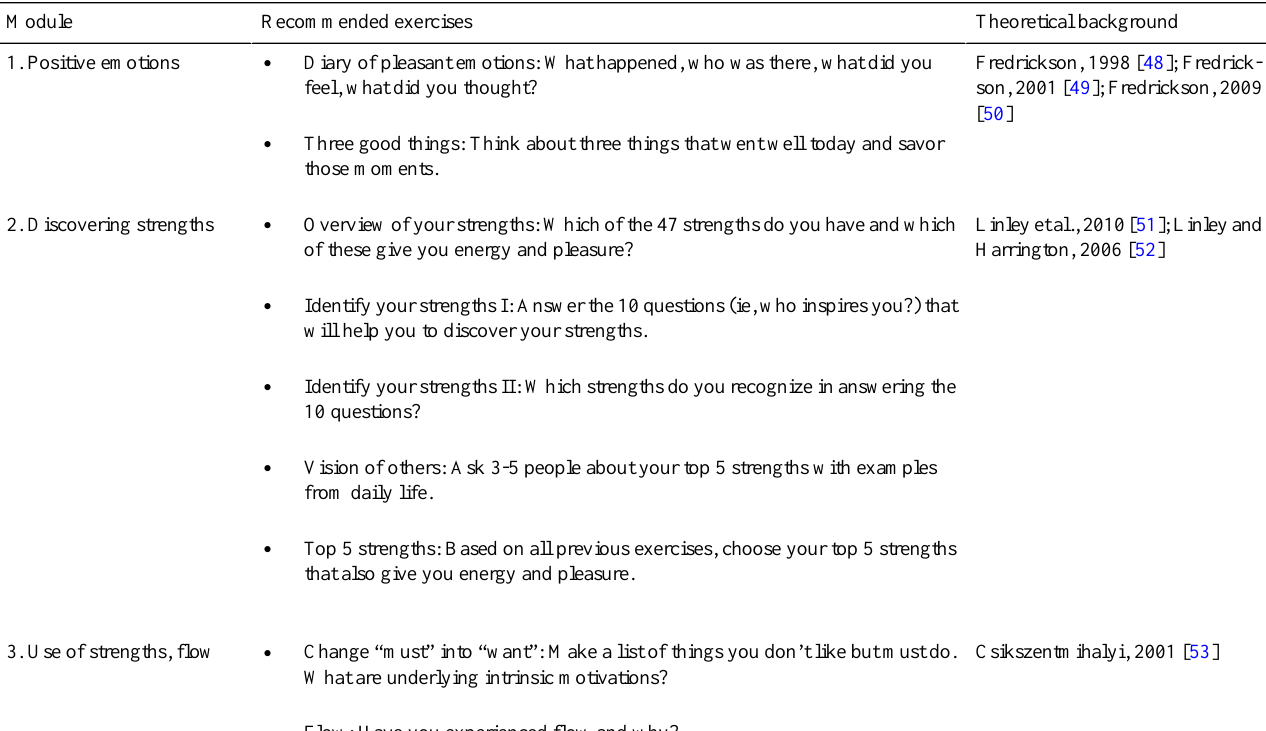
Table 1. Content of “This is your life” and recommended exercises for participants in the experimental conditions.